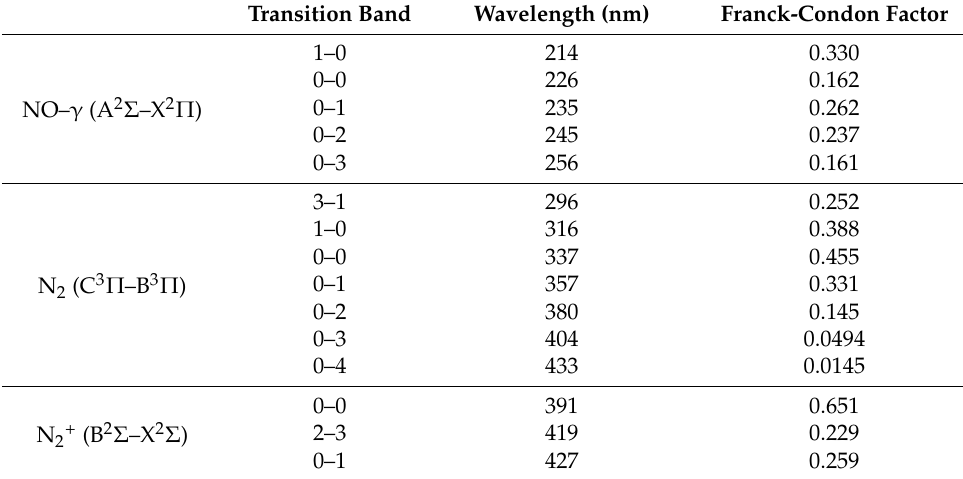
Table 1. Summary of the N 2 , N 2+ , and NO transitions and their corresponding emission wavelengths and Franck-Condon factors